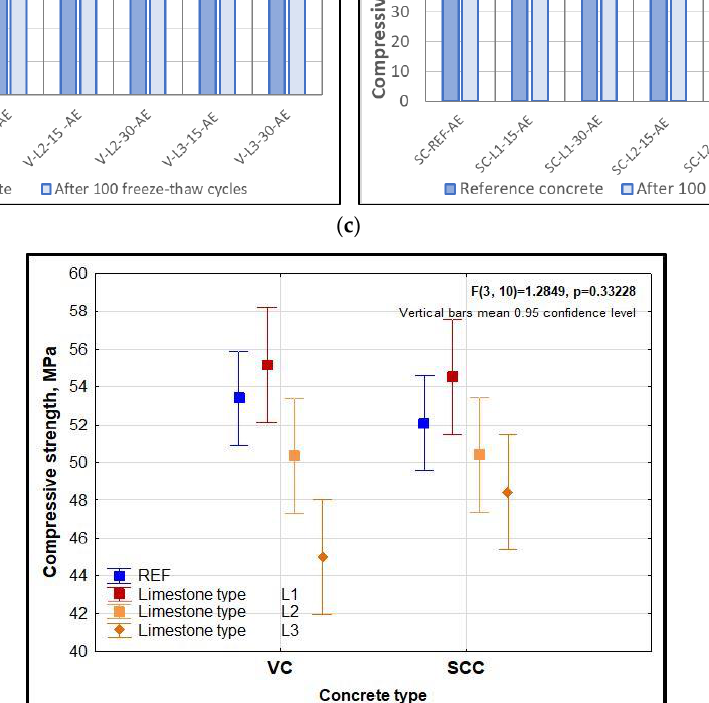
Figure 8. Compressive strength of ( a ) vibrated concrete and ( b ) self-compacting concrete, both with air-entraining admixture, with ( c ) ANOVA analysis of the effect of using limestone.